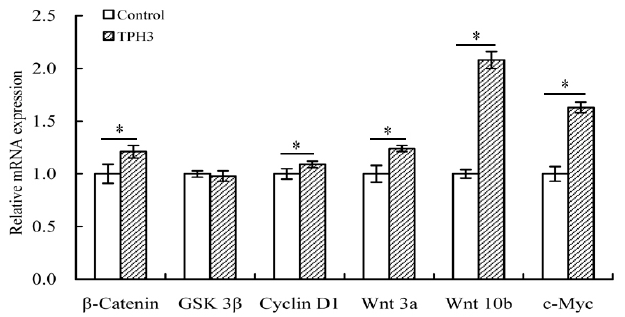
Figure 7. Expression changes of the genes in the osteoblasts. The cells were exposed to vehicle or TPH3 (0.05 g/L) for 48 h. Gene expression was normalized against β -actin. *: compared to control, p < 0.05.